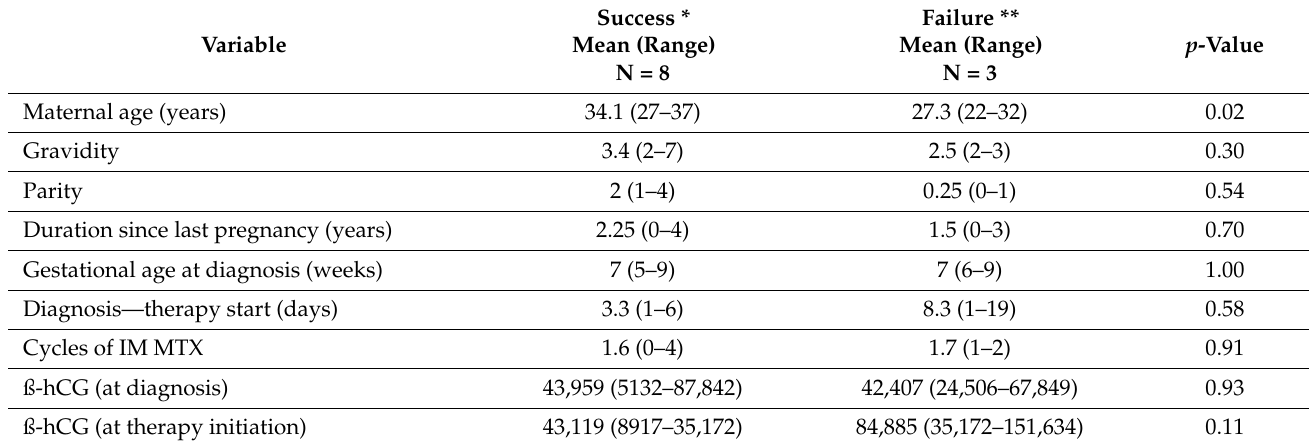
Table 3. Characteristics of patients with successful and failed MTX (IC/IM)